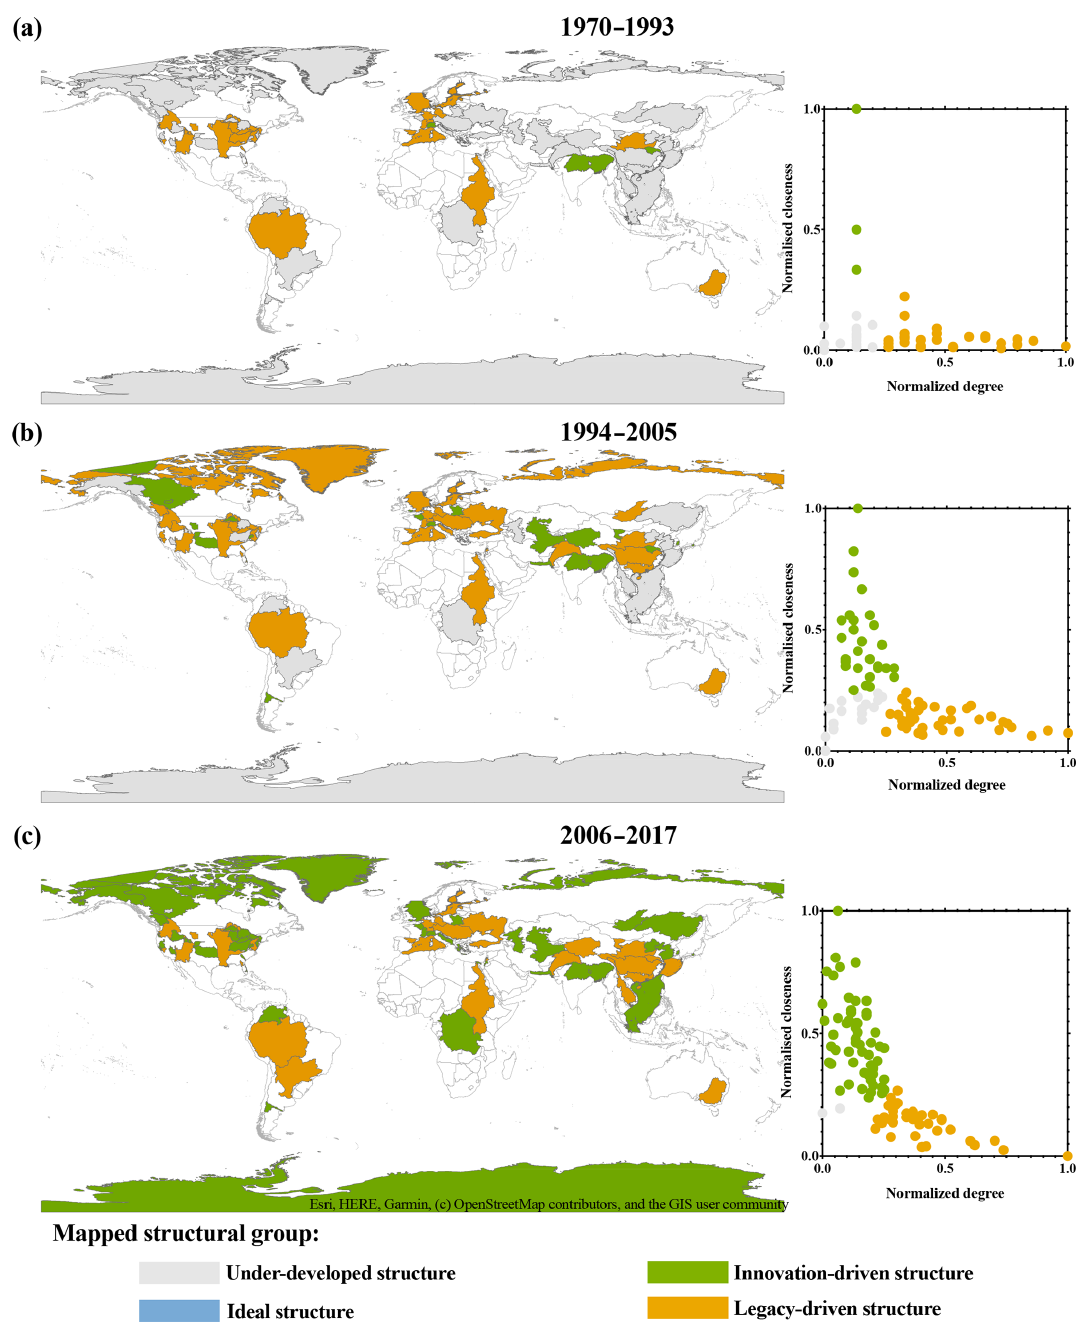
Figure 4. The spatial distributions of knowledge structure of 95 river basins (left) and corresponding structural metrics (right)